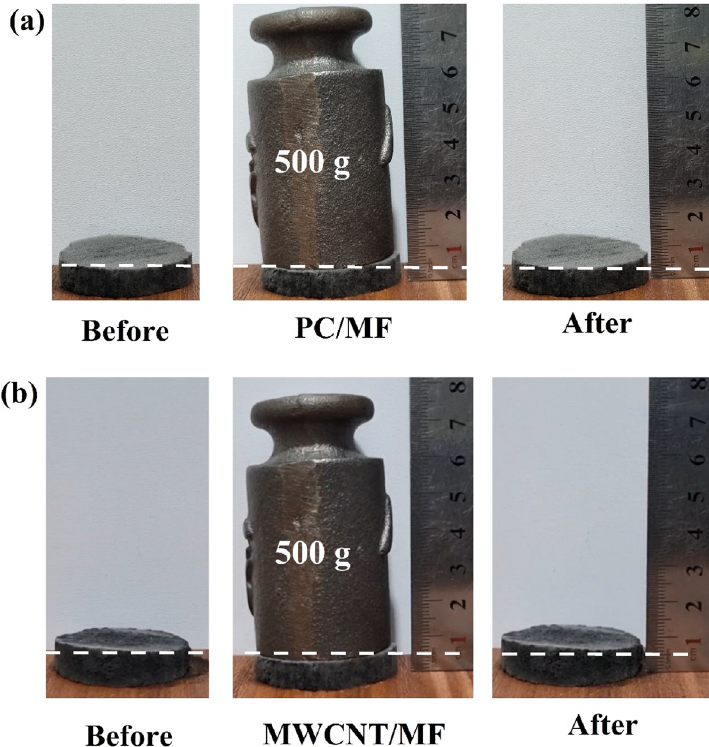
Figure 11. Mechanical strength test images of ( a ) the PC/MF and ( b ) MWCNT/MF before and after loading a